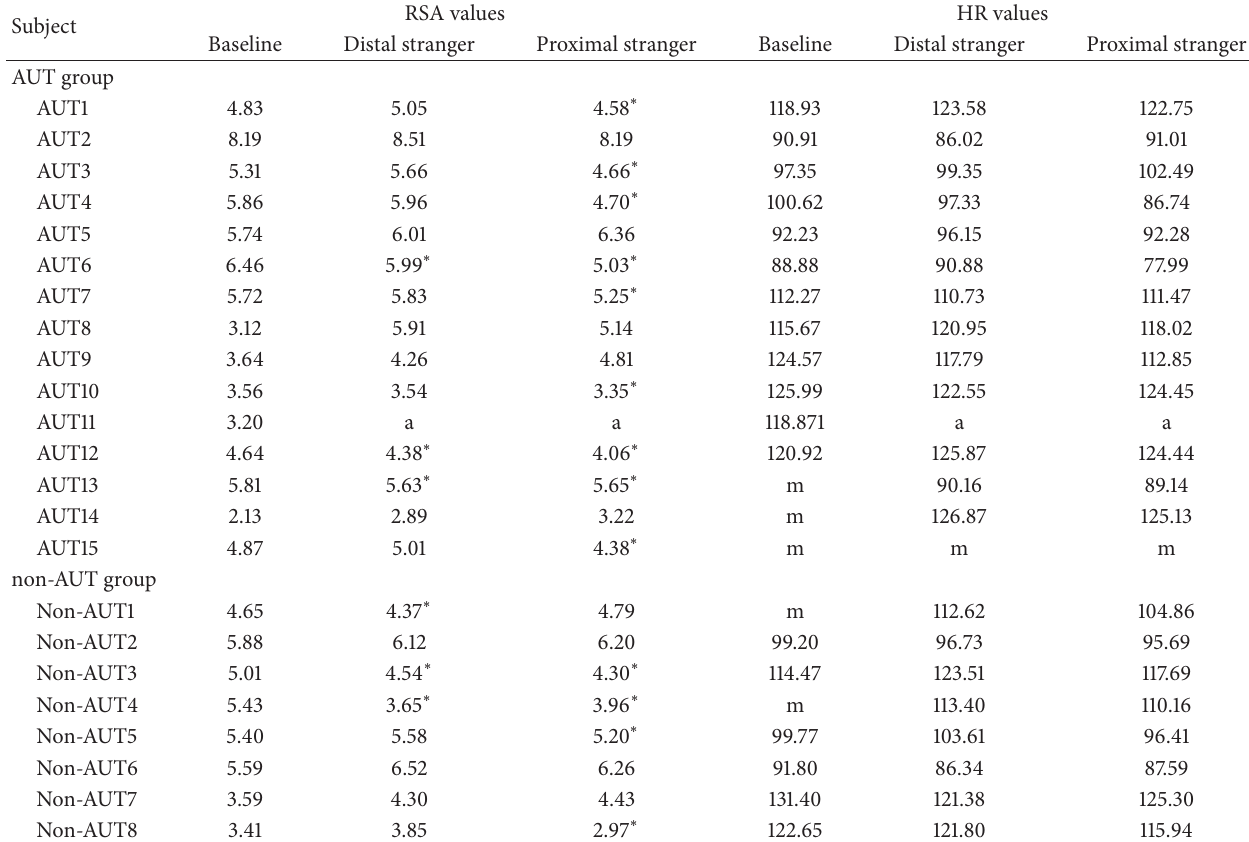
Table 3: Individual data values for RSA and HR for AUT and non-AUT participants.